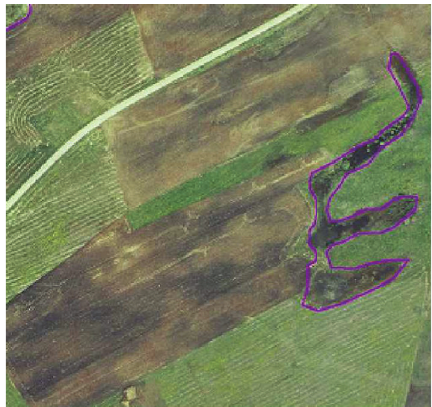
Figure 11: Arable land with boggy